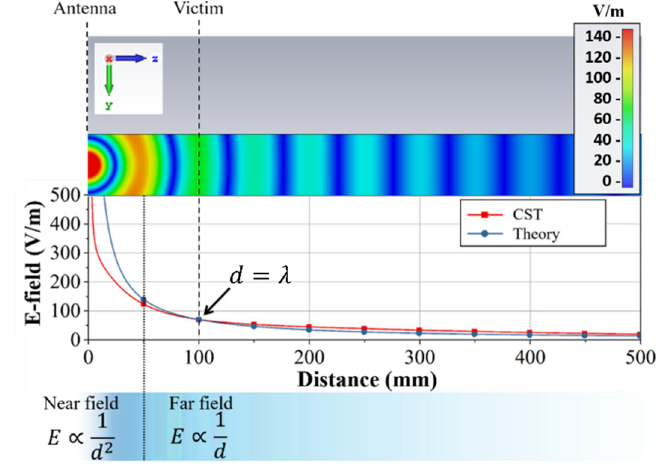
Figure 13. Simulation of E -field radiation from a 3 GHz half-wave antenna compared with theoretical E -field strength estimation in far field, in particular at the distance d = λ , where the subject is placed.